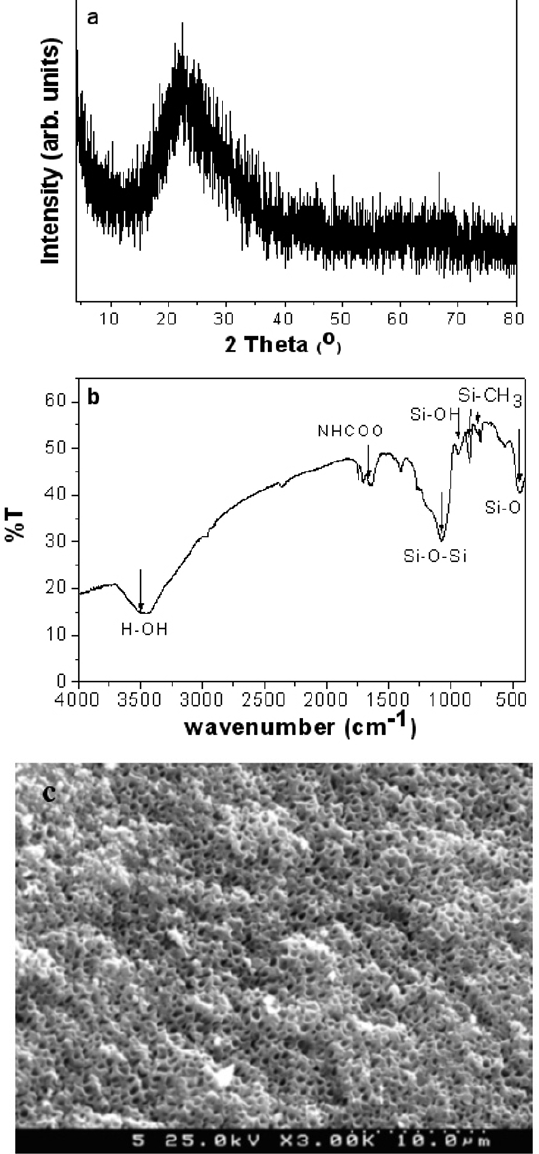
Figure 2. Investigation of the hybrid material Si-10Al by means of: a) XRD; b) FTIR and c) SEM